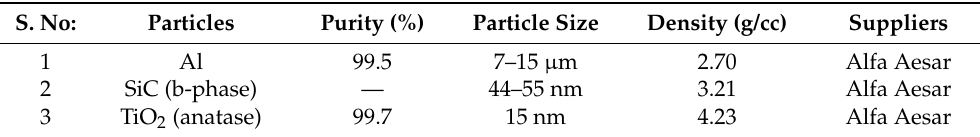
Table 1. Specifications of matrix and reinforcement